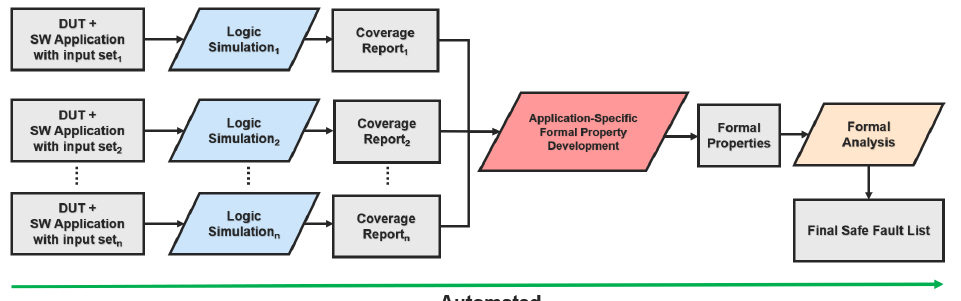
Figure 4. Proposed application-dependent safe fault identification